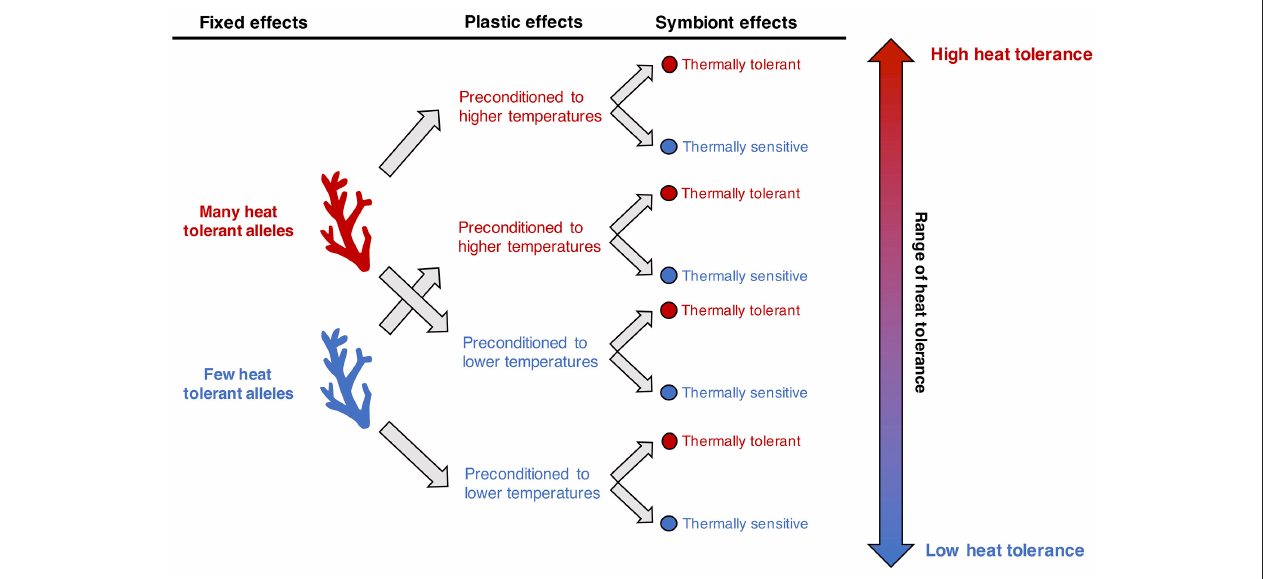
FIGURE 3 | Conceptual model for adaptation and acclimatization in generating thermal